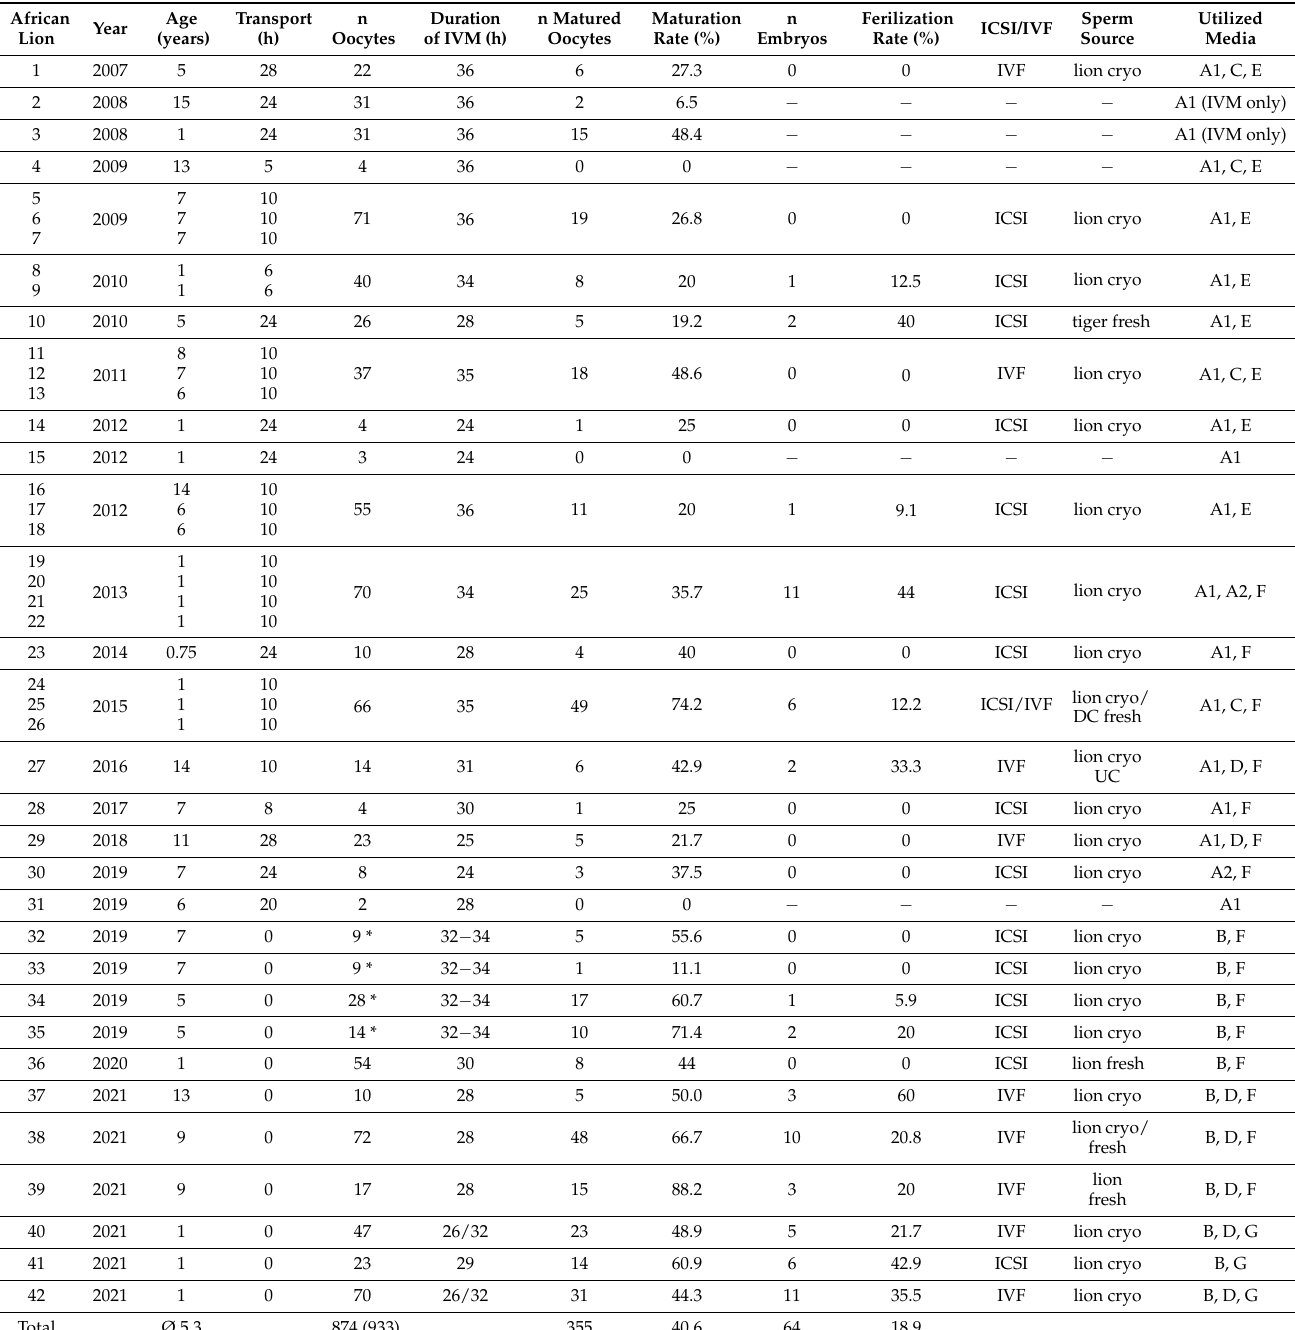
Table 1. Parameters and outcomes of IVF cascade for all